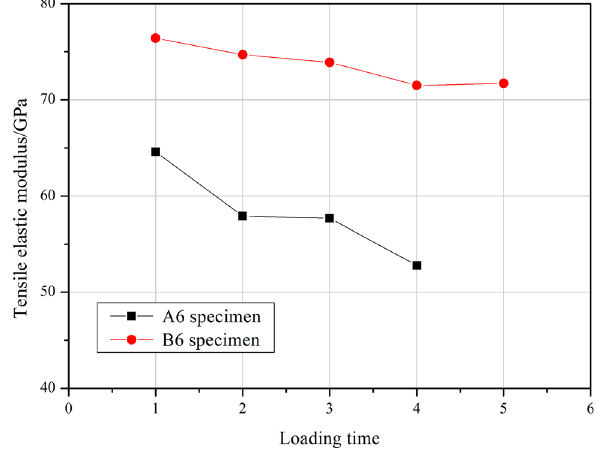
Fig. 7 Variation of elastic modulus in different tensile loading